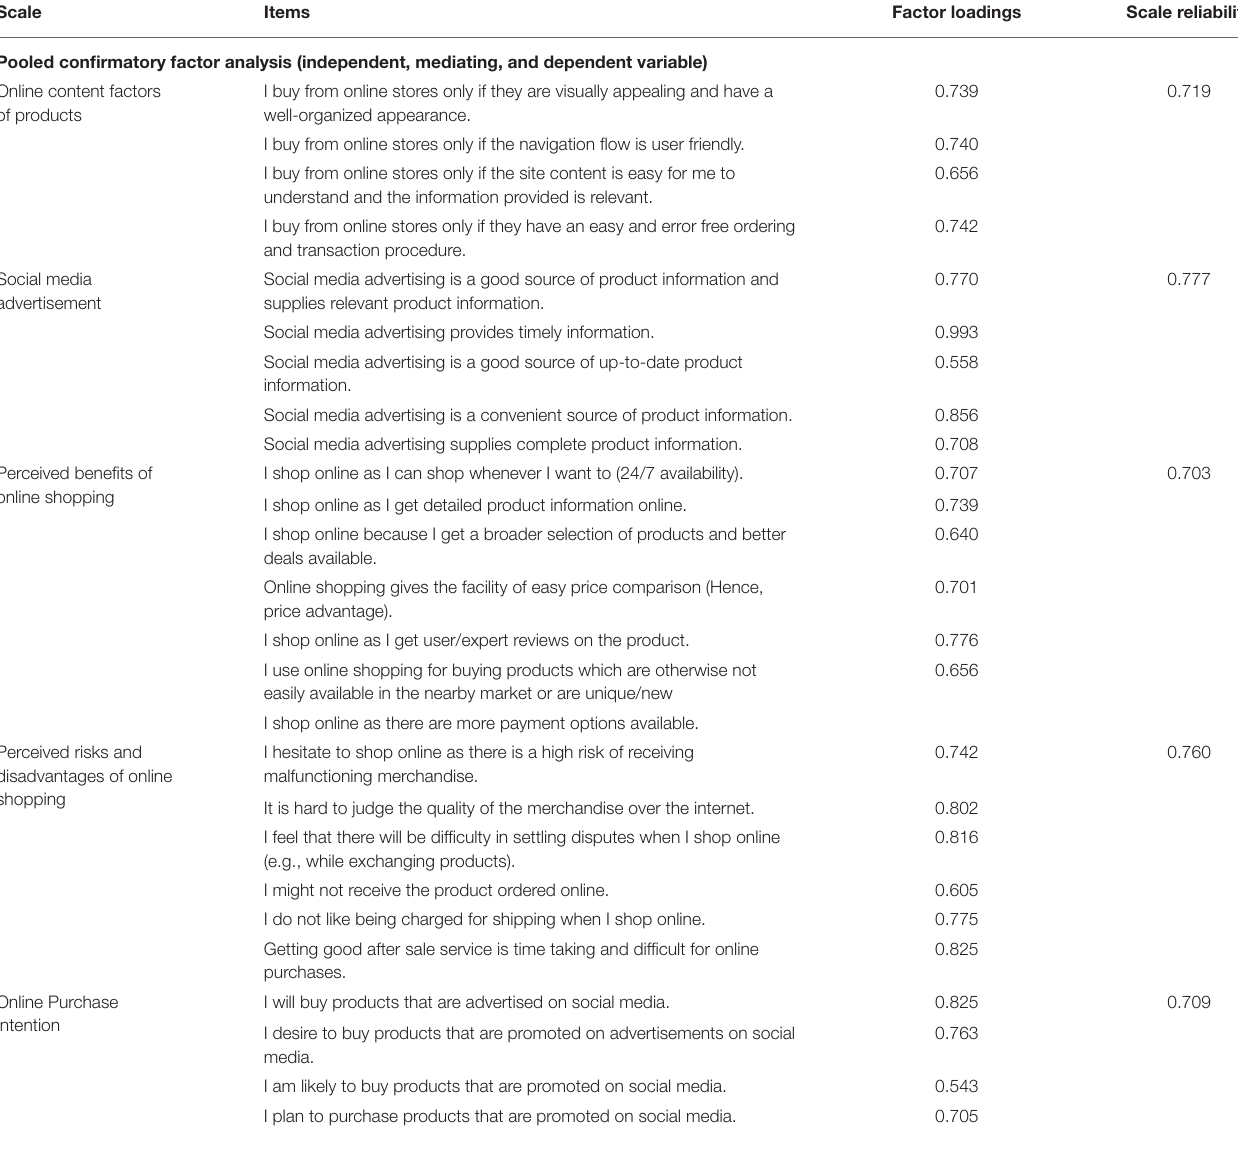
TABLE 3 | Pooled confirmatory factor analysis (Independent, mediating, and dependent